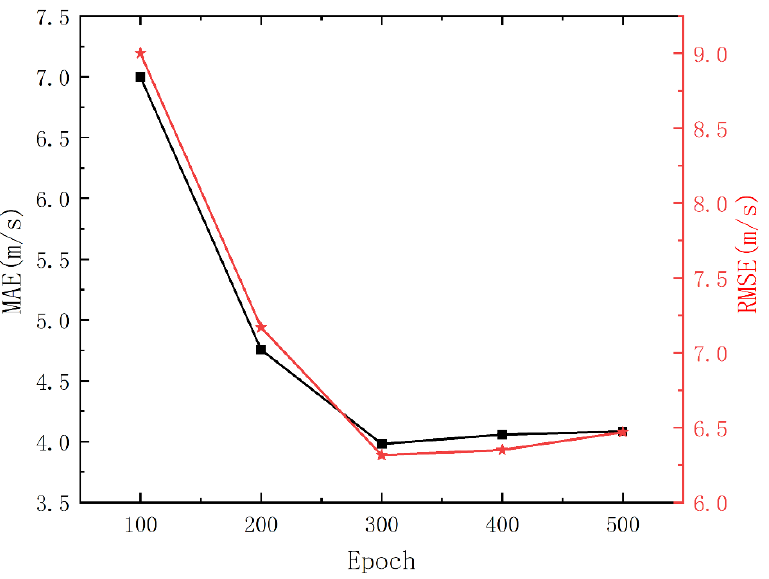
Figure 8. TITP-Net model forecasting results with the change of epochs in 24 h. The black line represents the forecasting MAE in 24 h with various epochs. The red line represents the forecasting RMSE in 24 h with various epochs.